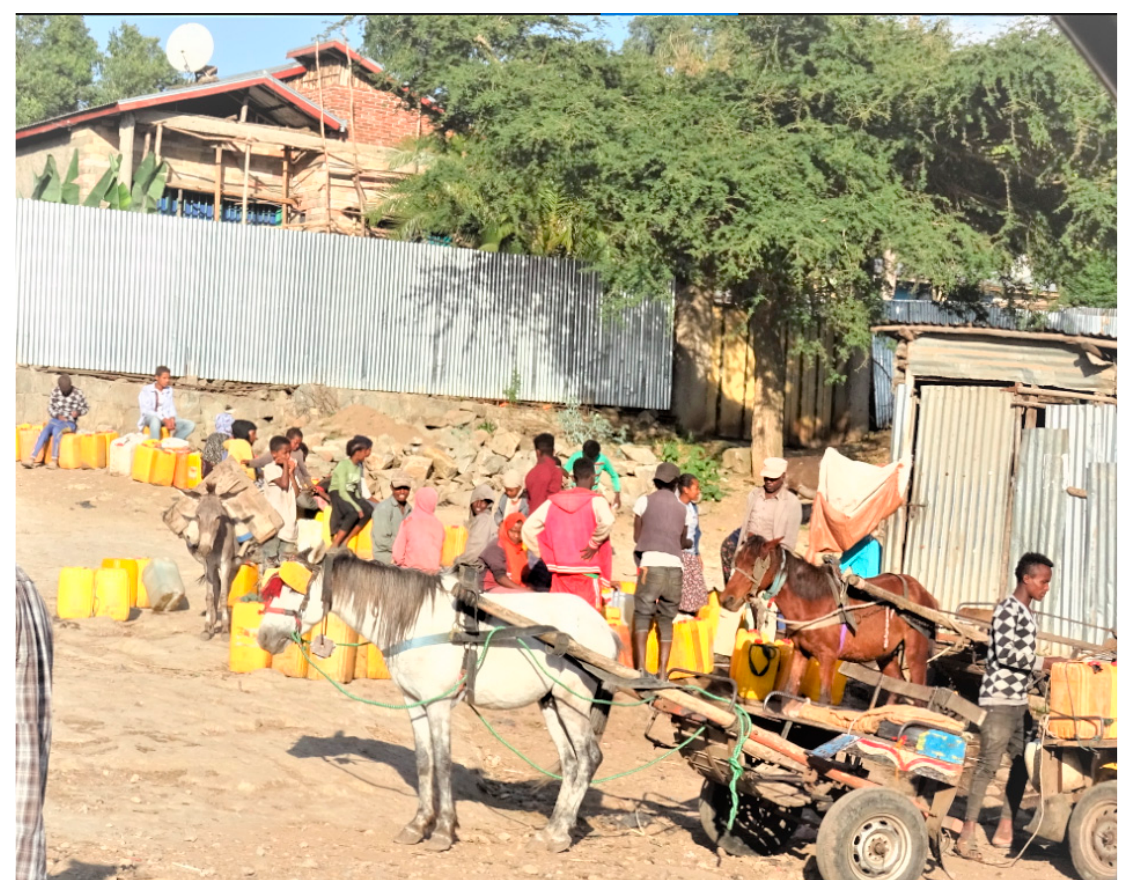
Figure 4. Rural water supply in Ziway Dugda woreda: photograph showing a line of yellow plastic jerrycans for domestic water, transported by a donkey cart from remote sources (photo by Taye Alemayehu, 2020).